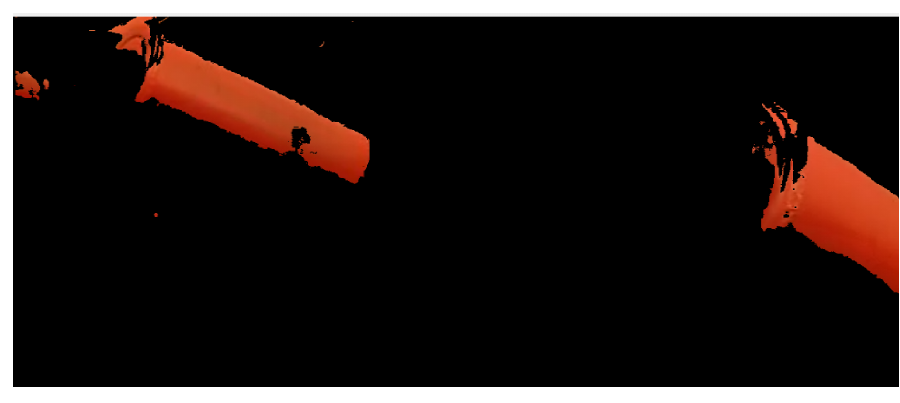
Figure 23. Segmented